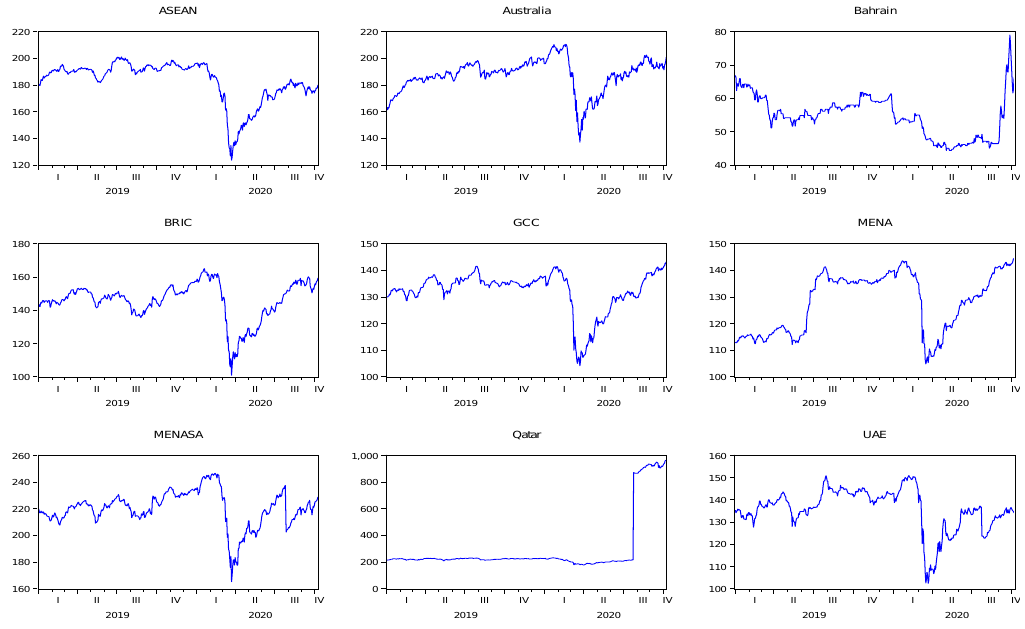
Figure 3. Market trend. Source: authors’ calculation using EViews 10.